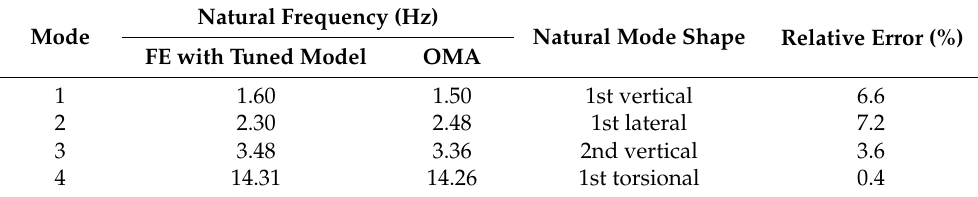
Table 3. Comparison of natural frequencies measured and calculated for the tuned model and description of the corresponding mode